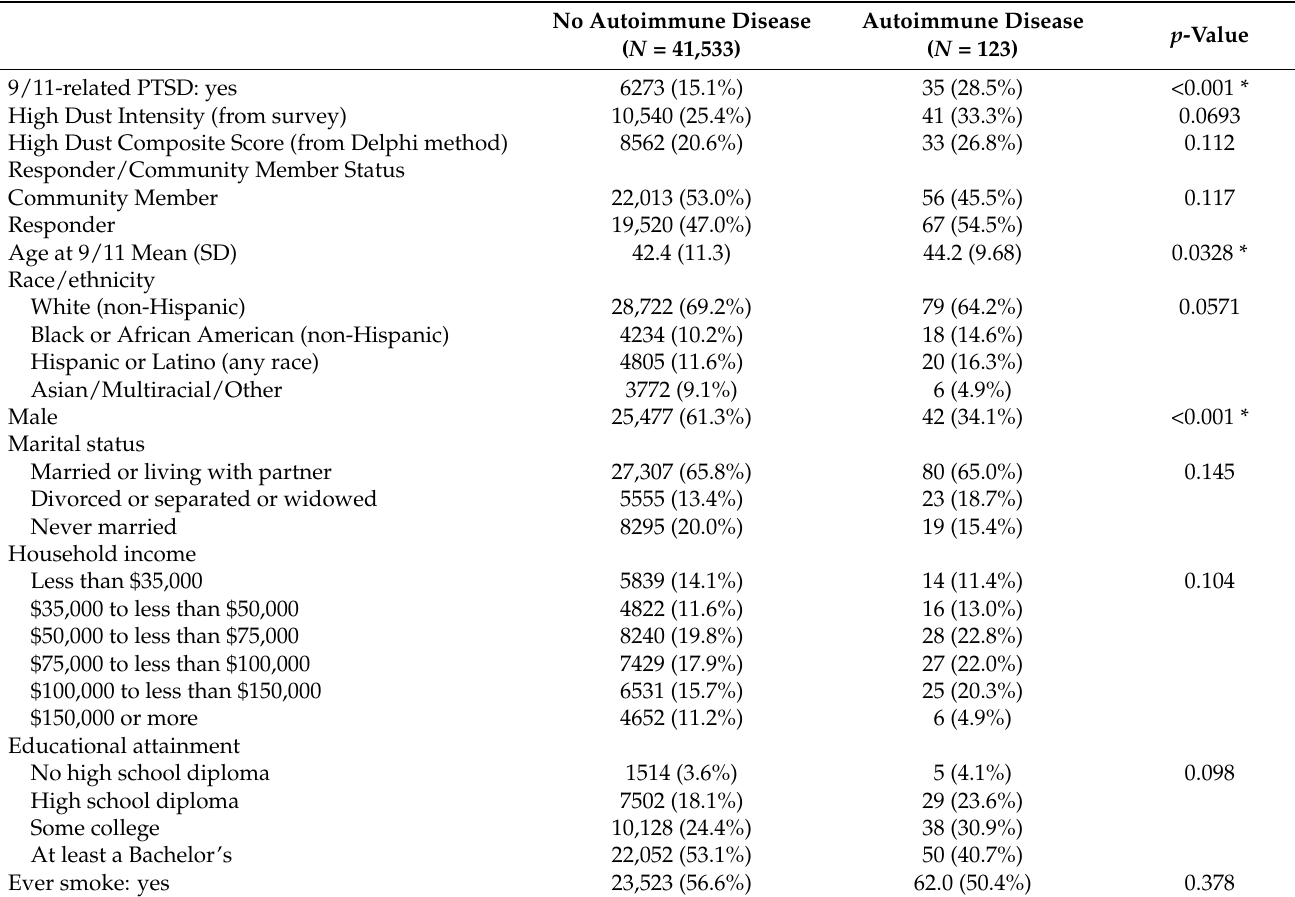
Table 1. Analytic sample characteristics of the World Trade Center Health Registry enrollees stratified by systemic autoimmune disease